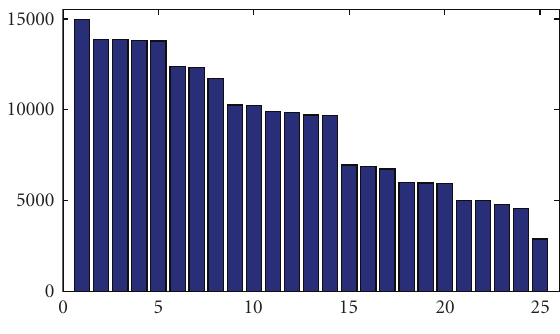
Figure 4: Generalized Hankel Singular Values ( γ i